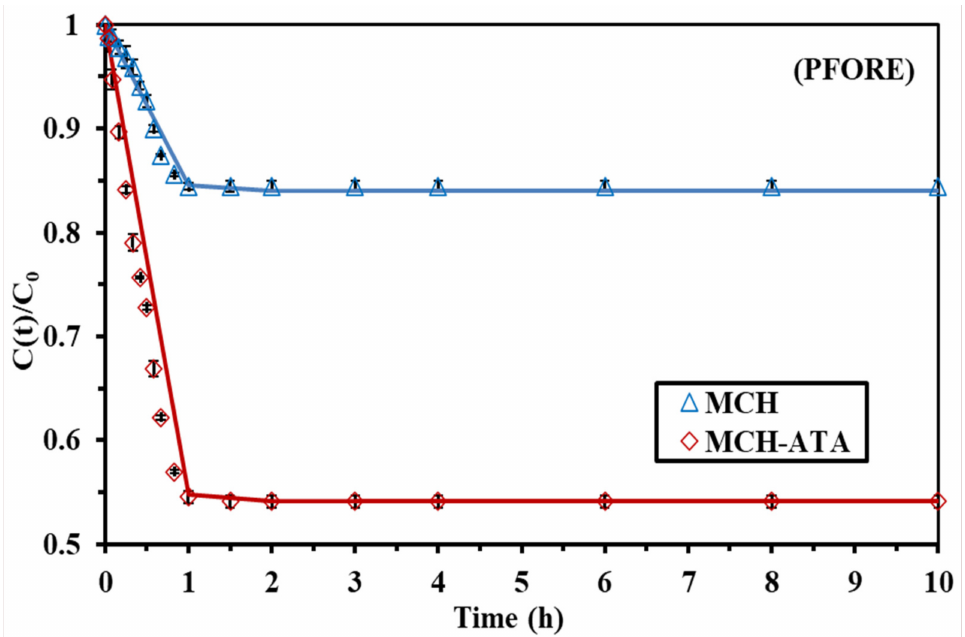
Figure 7. The average values with error bars of the three experiments for modeling of uptake kinetics of PFORE for MCH and MCH-ATA.